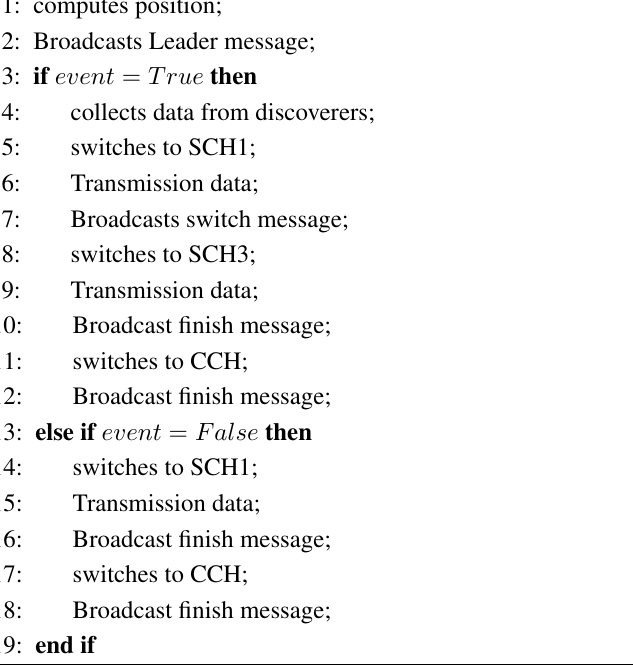
Algorithm 2 Data transmission procedure by the